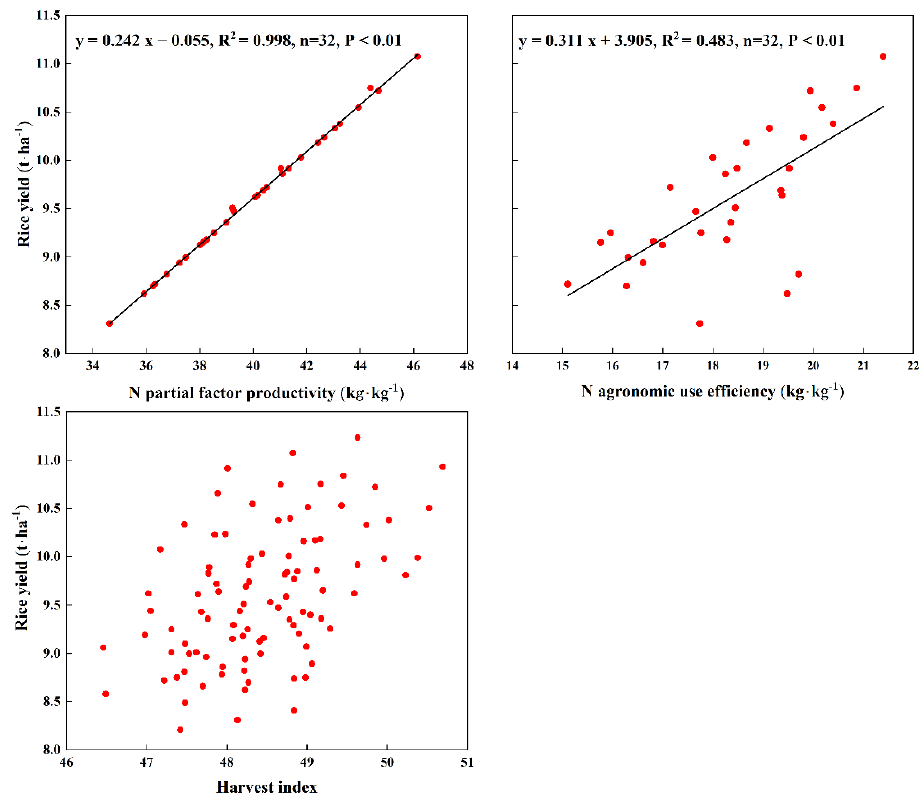
Figure 3. Correlation between rice yield and the dry matter utilization characteristics.